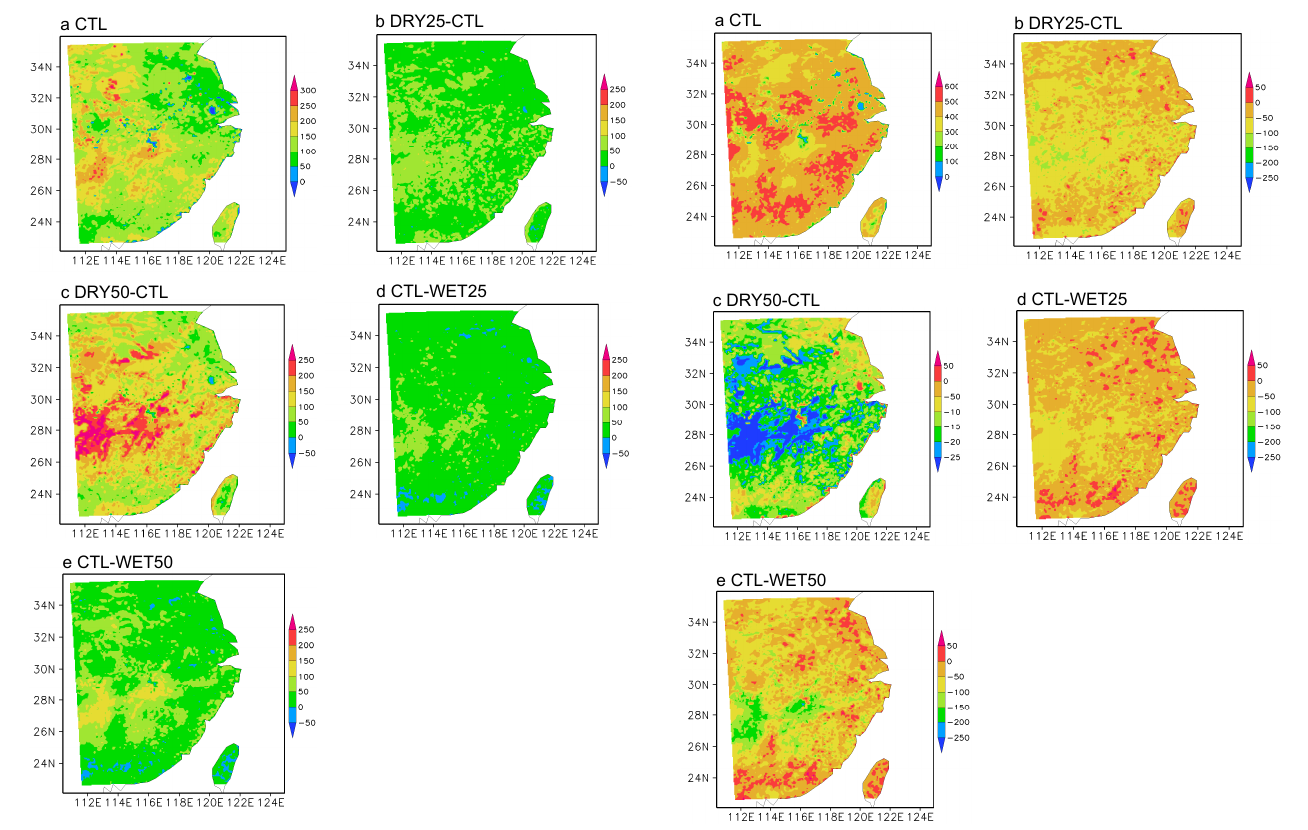
Figure 8. As Fig. 7 but for latent heat